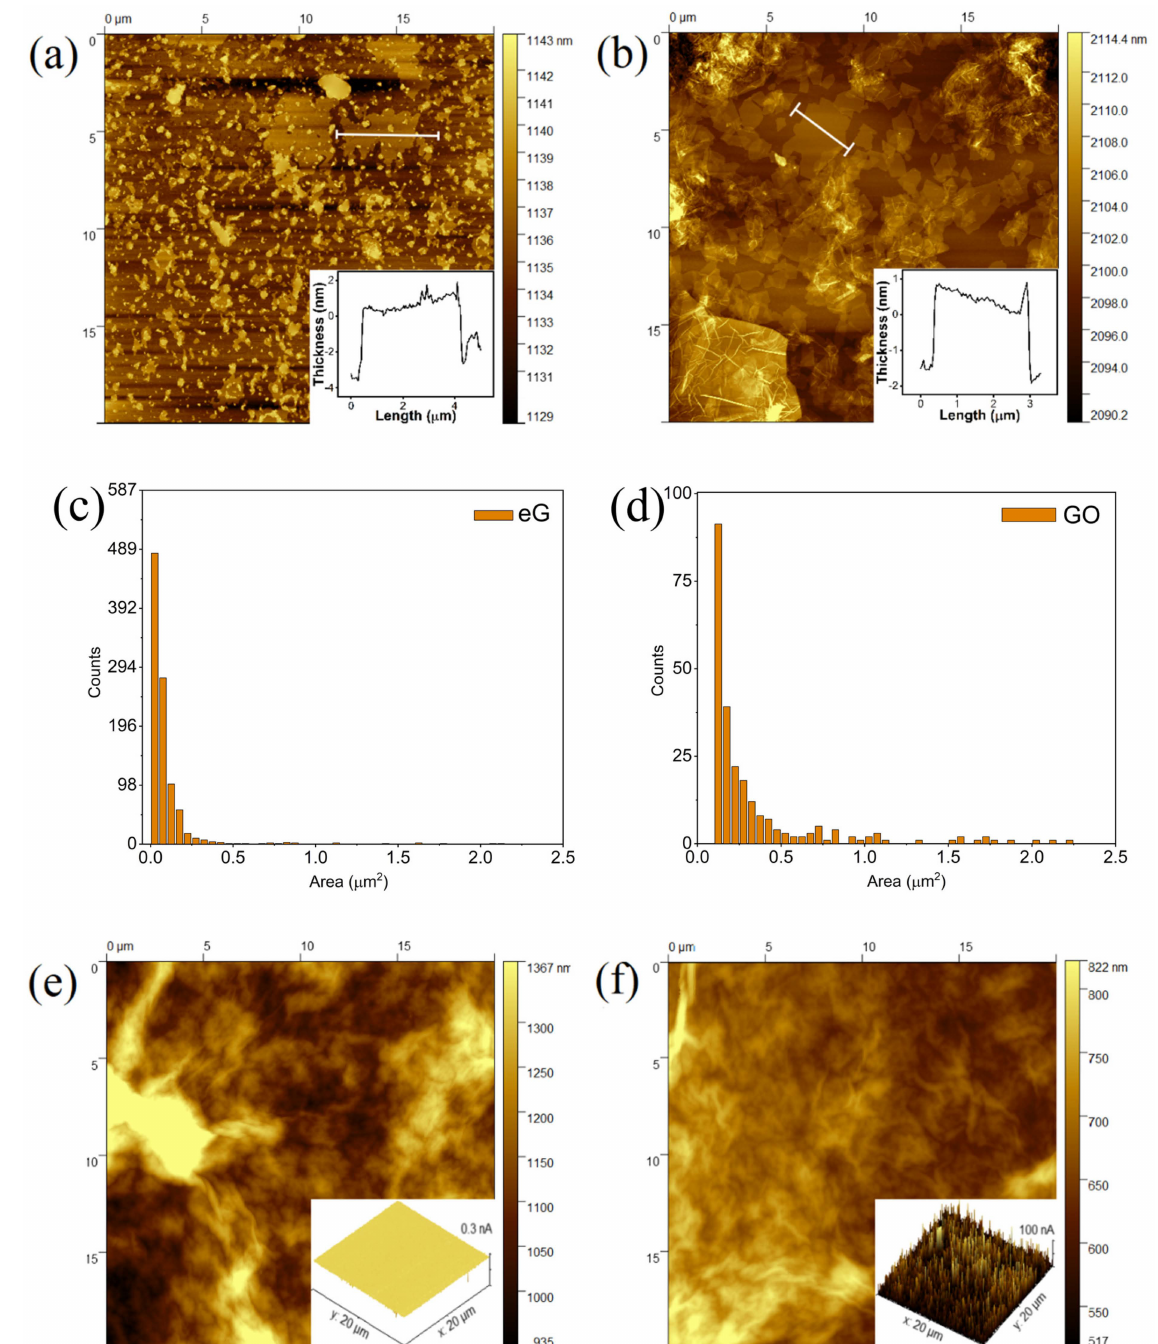
Figure 2. AFM and CS-AFM results for samples of ( a , b ) spin-coated eG and GO, respectively, and insets are the dimension of flakes; ( c , d ) the size statistic of spin-coated eG and GO from ( a , b ), respectively; for ( e , f ) drop coated GO before and after thermal annealing at 200 ◦ C, respectively, and insets are the CS-AFM